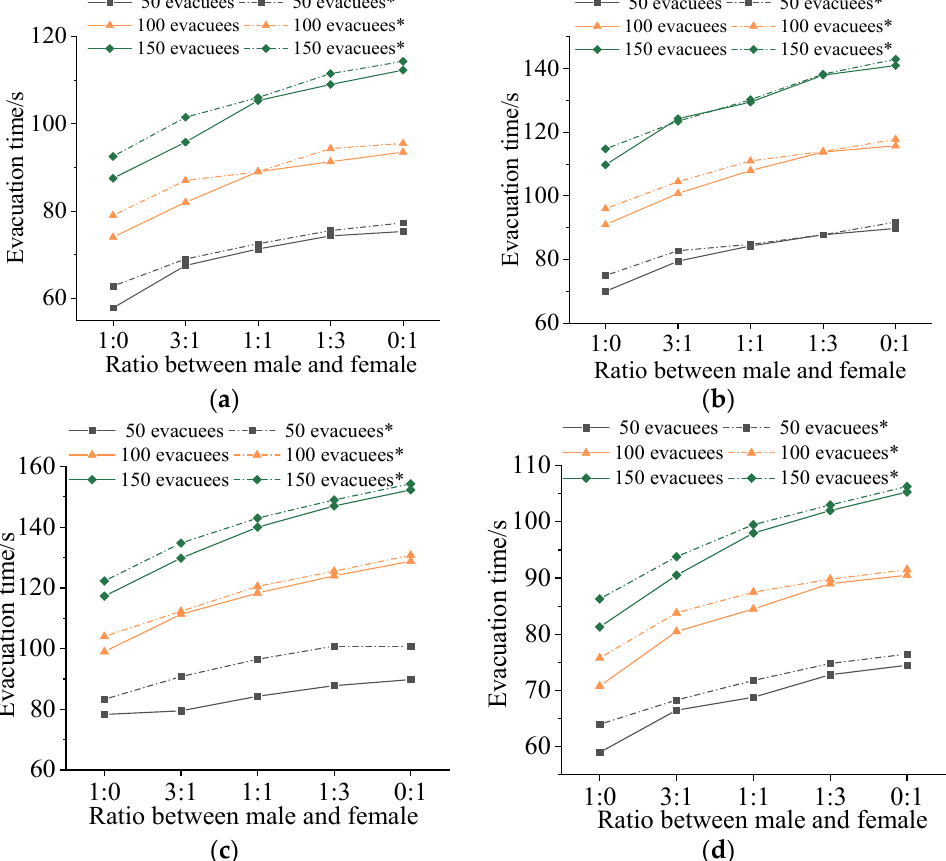
Figure 10. Effect of response time. ( a ) Straight running stairs with platform (SSP); ( b ) double running parallel stairs (DPS); ( c ) corner stairs (CS); ( d ) double split parallel stairs (DSS). Note: “*” means the simulation considering the response time.